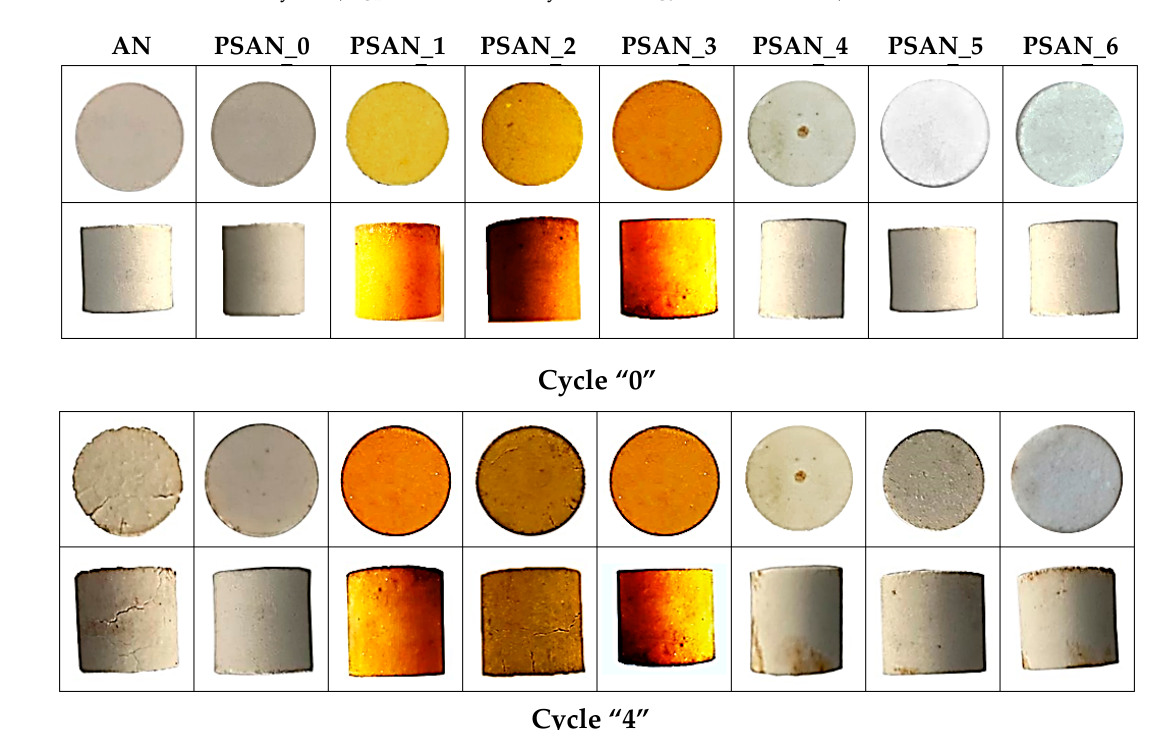
Figure 6. Volume variation for the sample containing neat AN and PSAN_6 after four heating–cooling cycles ( V C4 —volume after cycle “4”; V C0 —initial volume).